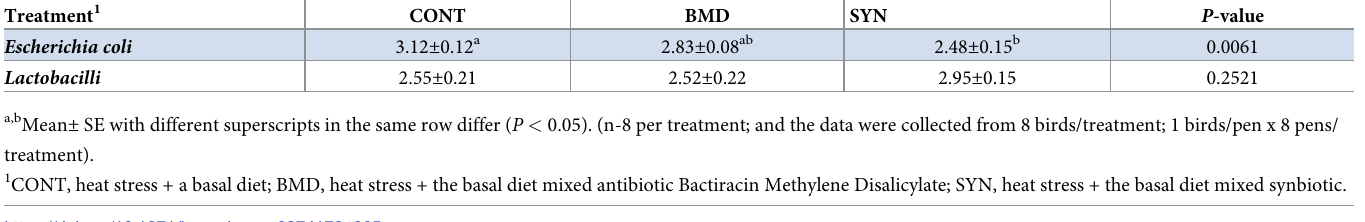
Table 5. Effect of dietary supplementation of synbiotic (SYN) and antibiotic (BMD) on cecal bacterial populations ( Escherichia coli and Lactobacilli ) of broiler chickens reared under heat stress condition. Treatment 1